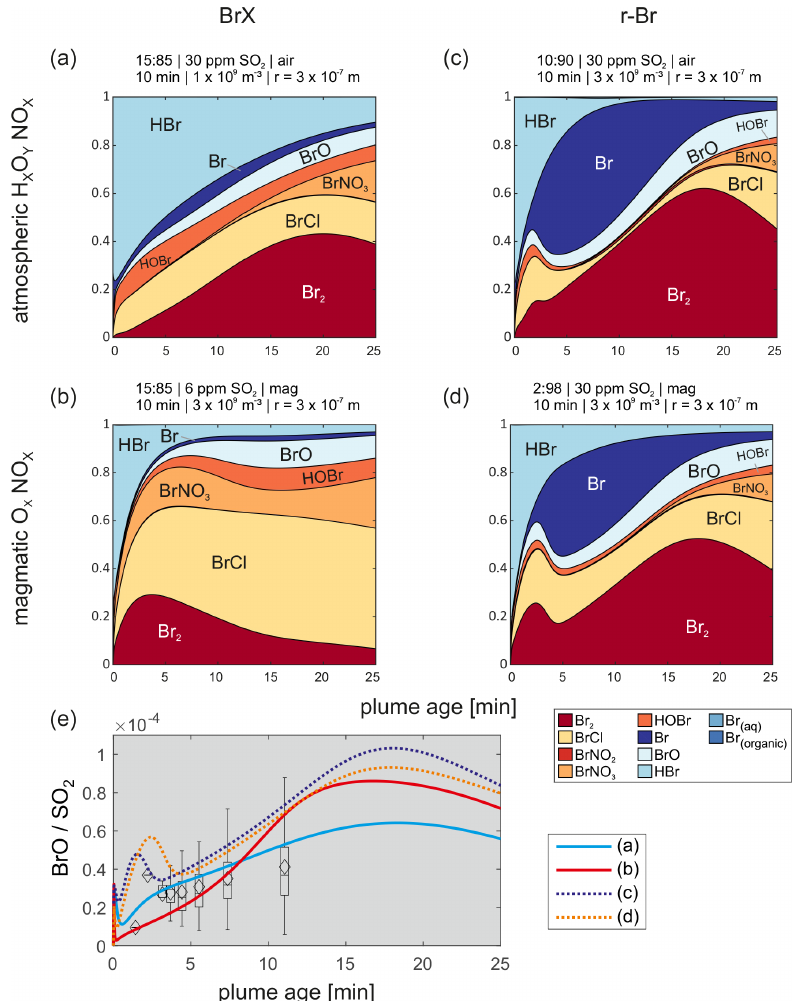
Figure 7. (a–d) Detailed bromine speciation for the first 25min of the four selected model runs closest to the measured Br X / Br, r-Br / Br, and BrO / SO 2 progressions. Four different model scenarios are shown, which fit best to the measurement data, using the progressions of Br X / Br and r-Br / Br with magmatic and ambient air oxidant amounts, respectively. Panel (e) shows the corresponding BrO / SO 2 ratios for the model runs in panels (a) – (d)